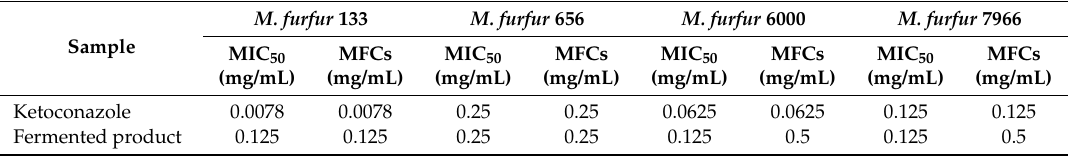
Table 3. The minimum inhibitory concentrations required for 50% growth reduction when compared with the extract-free Sabouraud Dextrose Broth (MIC 50 ) and minimal fungal concentrations (MFCs) of the fermented product of O. sanctum against four strains of M.